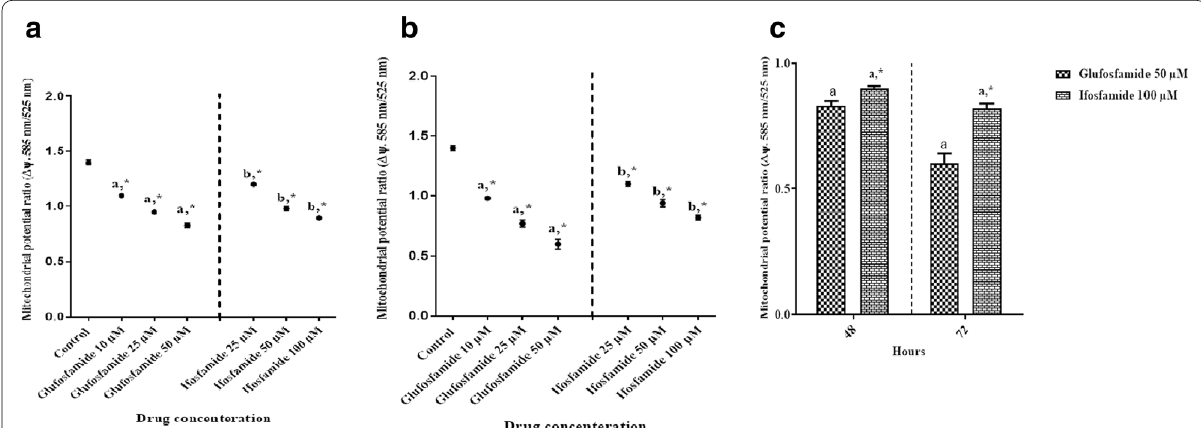
Fig. 6 Effects of glufosfamide and ifosfamide on the mitochondrial membrane potential (Δψm) in HepG2 cells. a Effects of glufosfamide or ifosfamide on the mitochondrial membrane potential in HepG2 cells following exposure to 48 h. b Effects of glufosfamide or ifosfamide on the mitochondrial membrane potential in HepG2 cells following exposure to 72 h. c Comparative effects of the IC50 of glufosfamide and ifosfamide on the mitochondrial membrane potential in HepG2 cells following exposure for 48 and 72